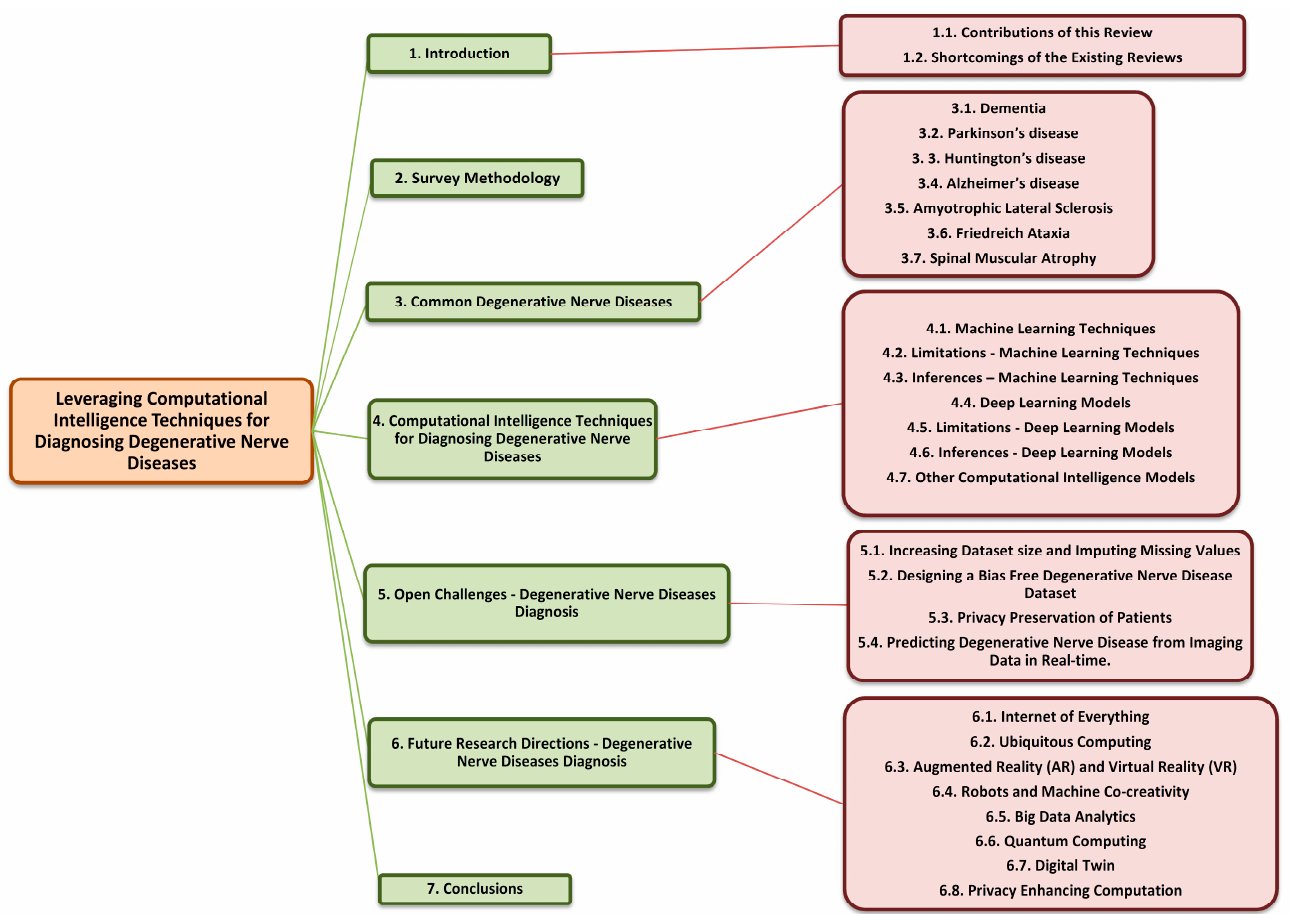
Figure 3. General structure of this review article.